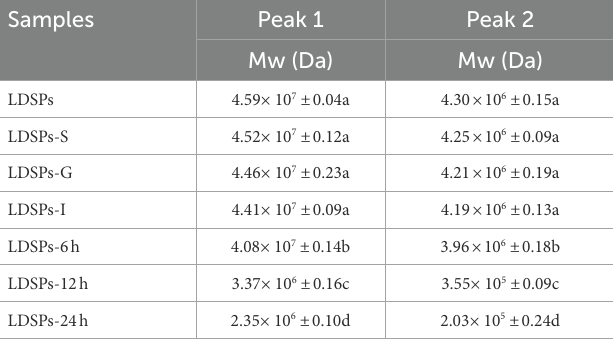
TABLE 3 Changes in molecular weight of LDSPs during in vitro digestion and fermentation. Samples